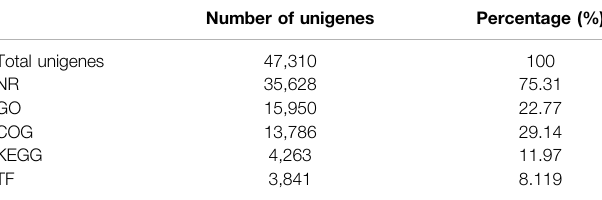
TABLE 1 | Summary of annotations against publicly available databases.